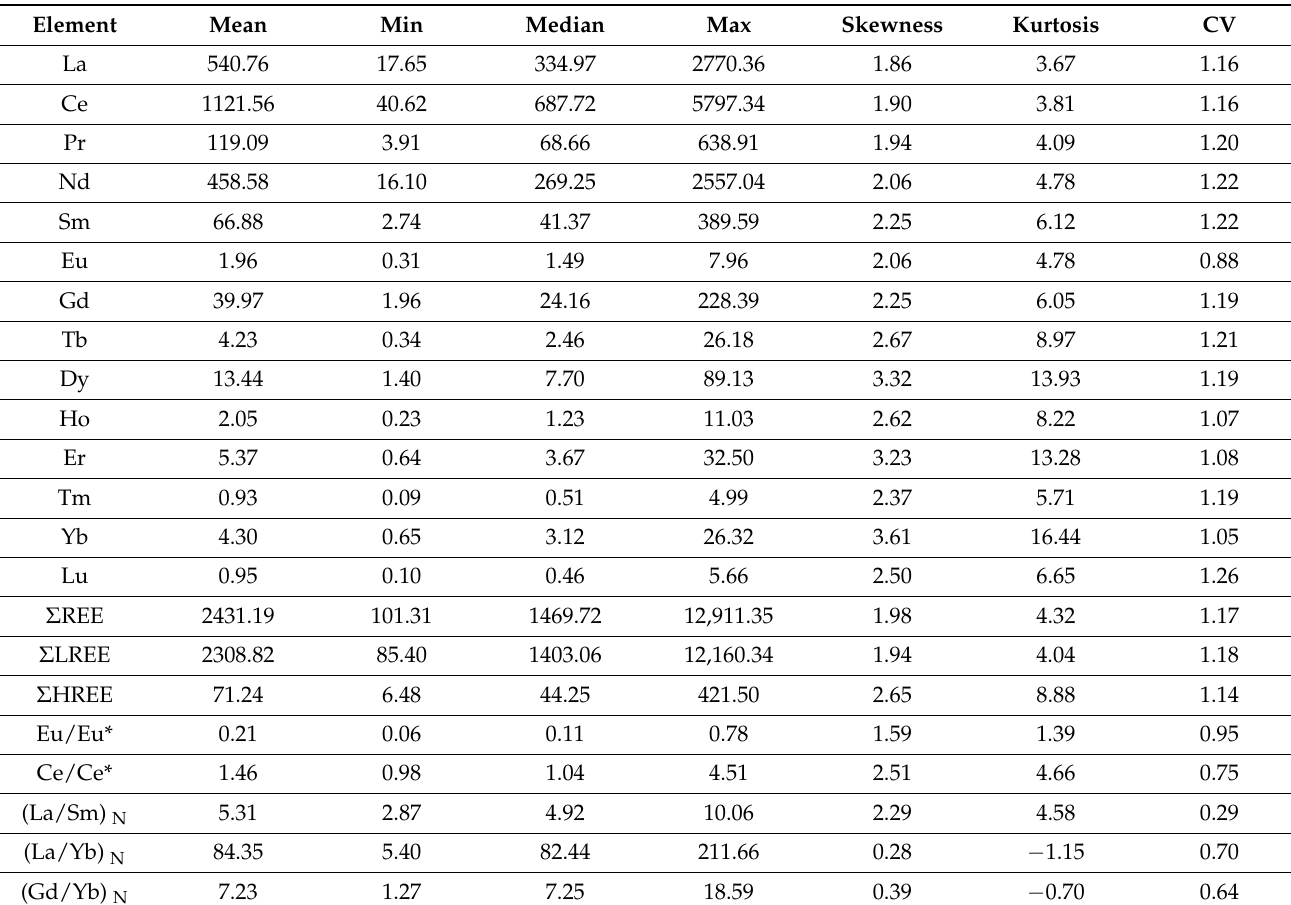
Table 5. Descriptive statistics of REEs ( µ g g − 1 ) in soils ( n = 36).